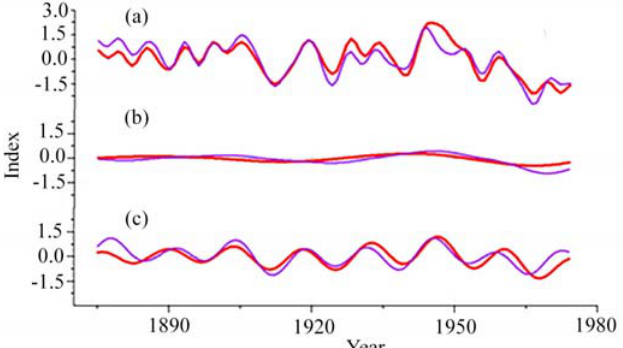
Fig. 10: R-MXD decomposition of group I (red curve) and group II (blue curve) into components: (a) regional МХD1 and МХD2; (b) long-term trends; and (c) UV-B signal (group I) and climatic signal (group II)